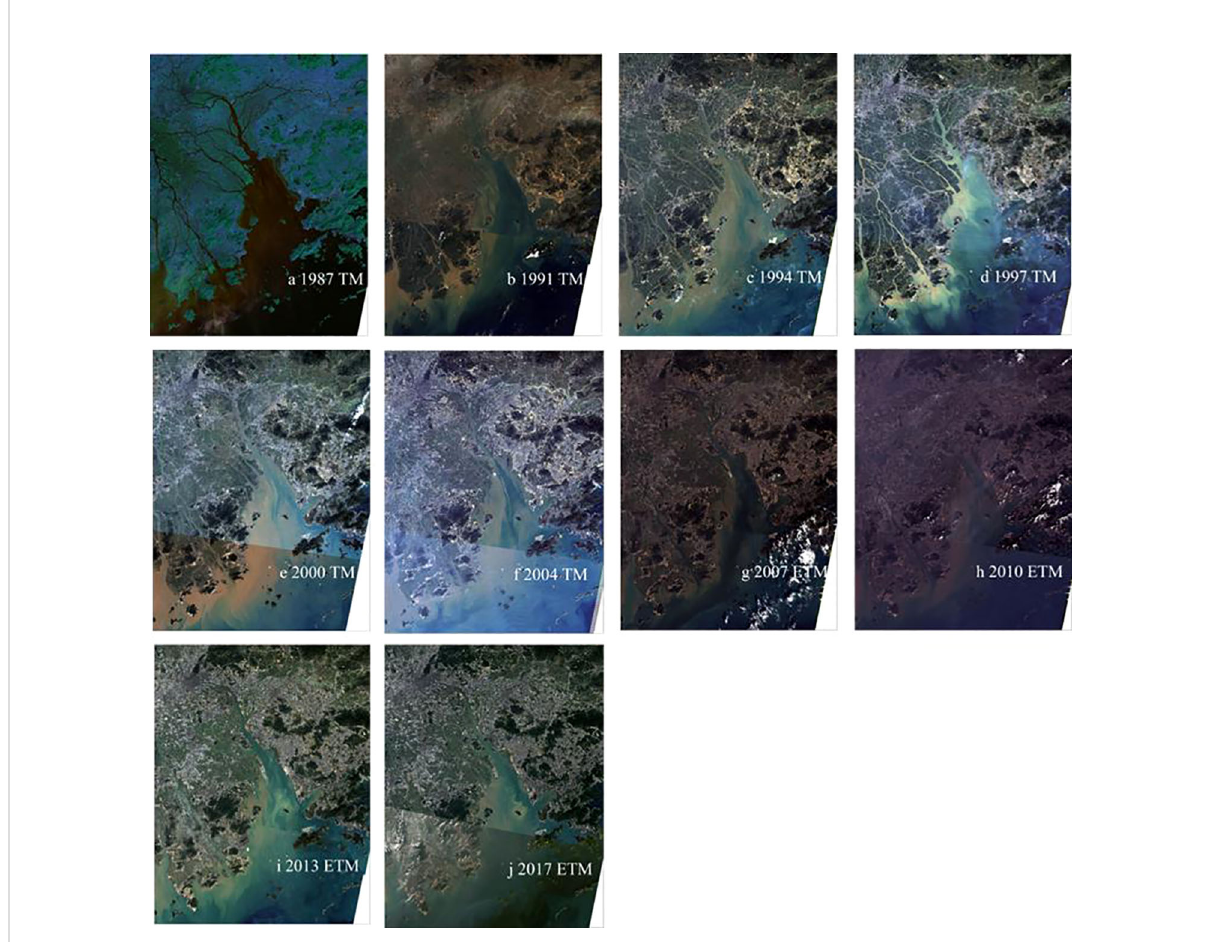
FIGURE 2 Remote sensing images of the study area from 1987 to